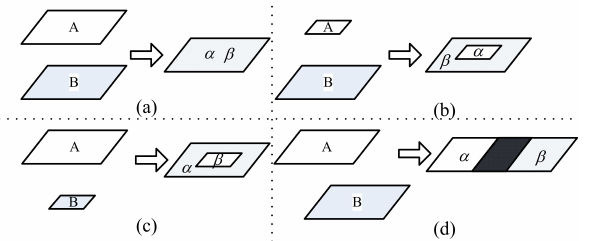
Figure 3. Four different cases of projections with overlaps.